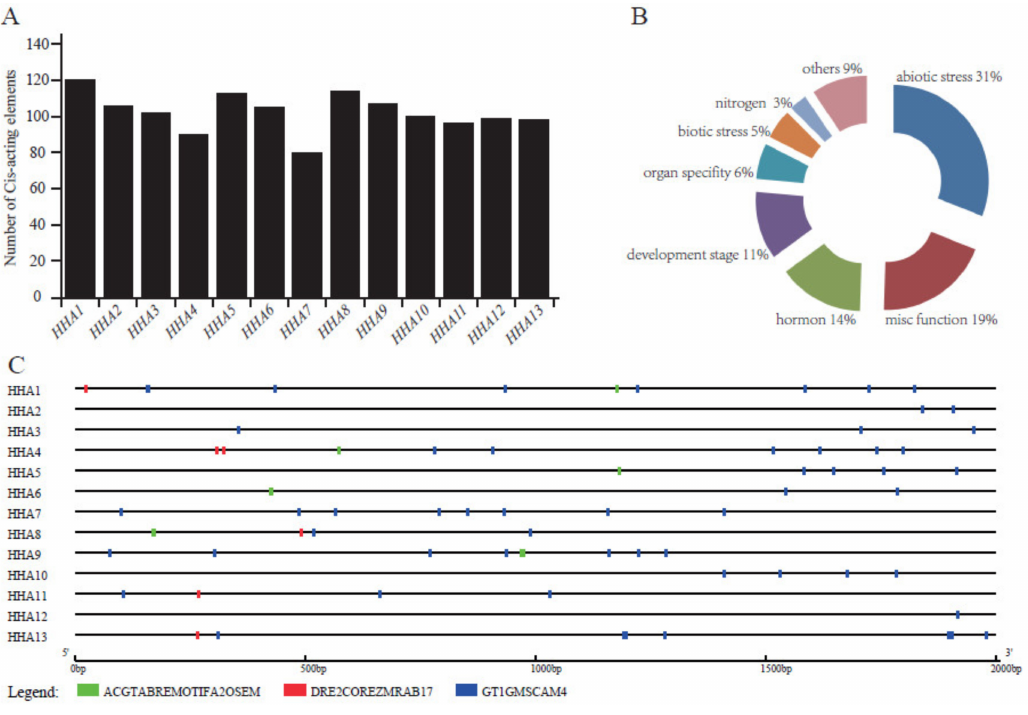
Figure 4. Frequency of Cis -acting elements in the 2 kb length promoter of HHAs . Statistical result of the number of non-repetitive Cis-acting elements of each HHA gene (A), the environmental-responsive Cis -acting elements (B), and the distribution of three salt stress-related Cis -acting elements in each of HHA gene promoter region